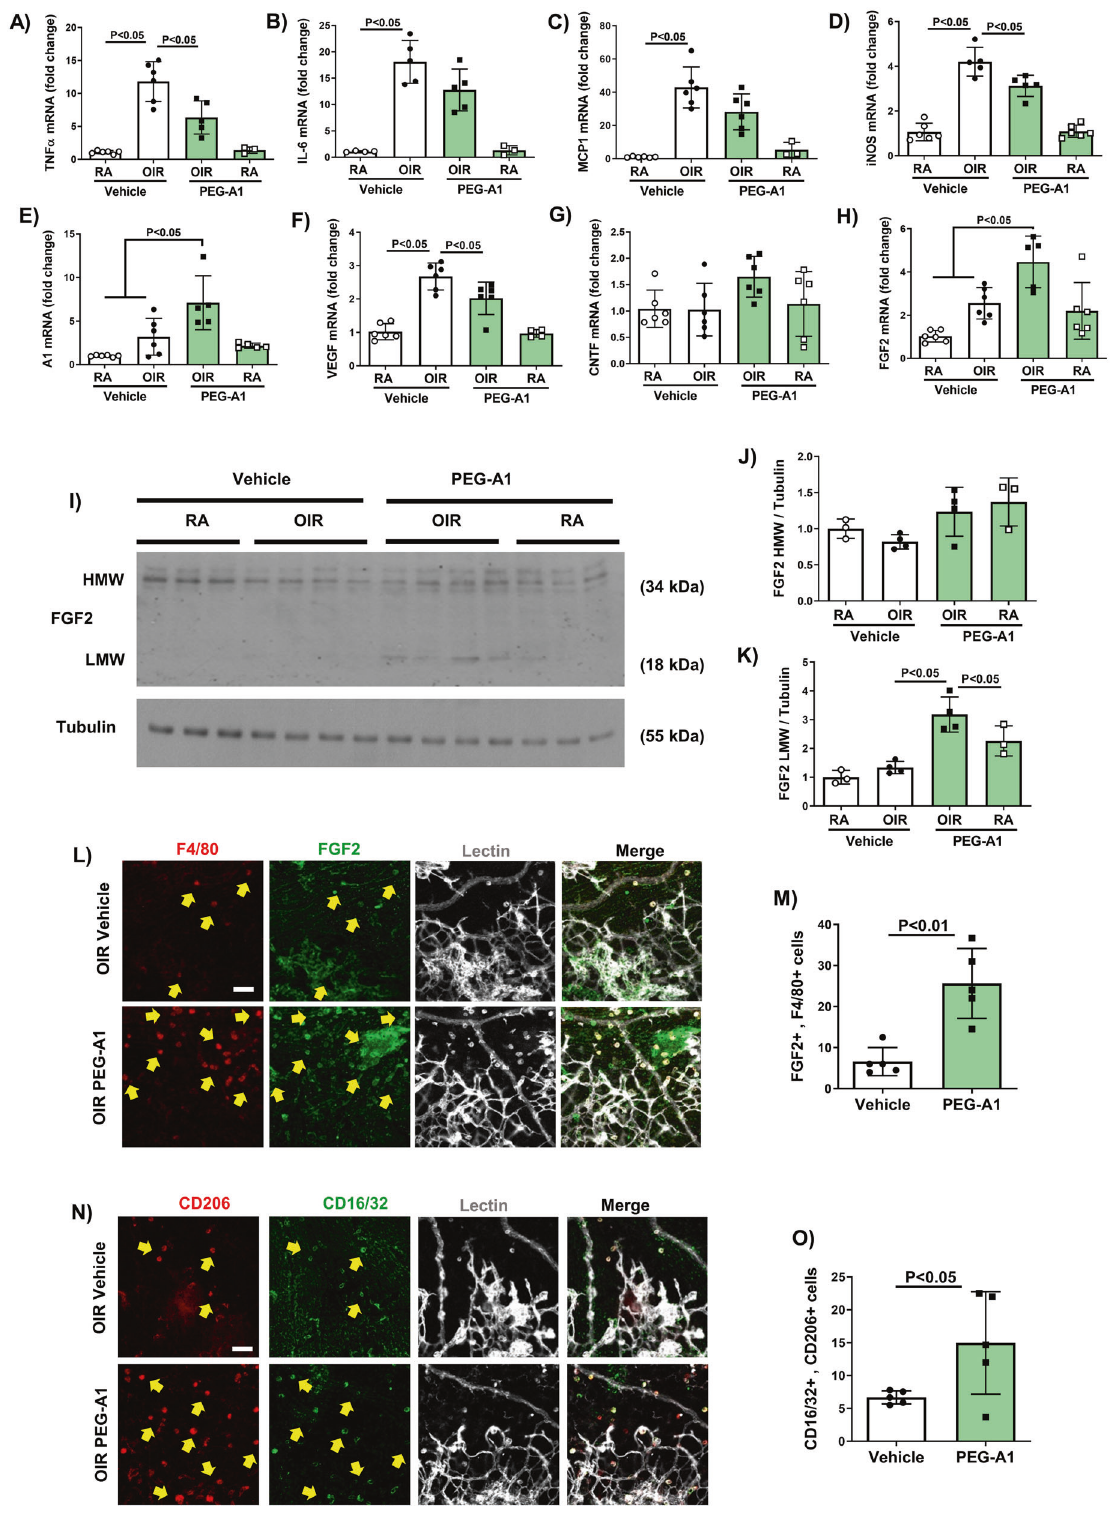
from non-diabetic controls (Fig. 6A). Similarly, immunolabeling studies of the mouse retinas during the RNV phase of OIR showed co-localization of A1 with blood vessels as well as microglia/ macrophages in retina sections (Fig. 6B) and fl atmounts (Fig. 6C). To gain insight on how amino acids and polyamines involved in the arginase pathway changed in the OIR retinas in response to